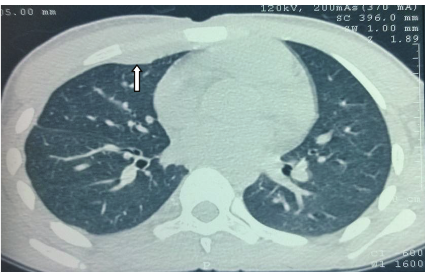
Figure 3: Axial CT image at lesion level in lung window showing no evidence of lung parenchymal involvement.